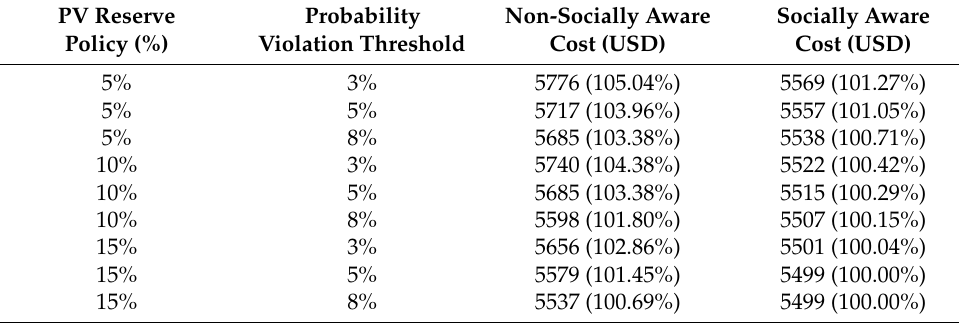
Table 3. Total System Operation Cost for Case